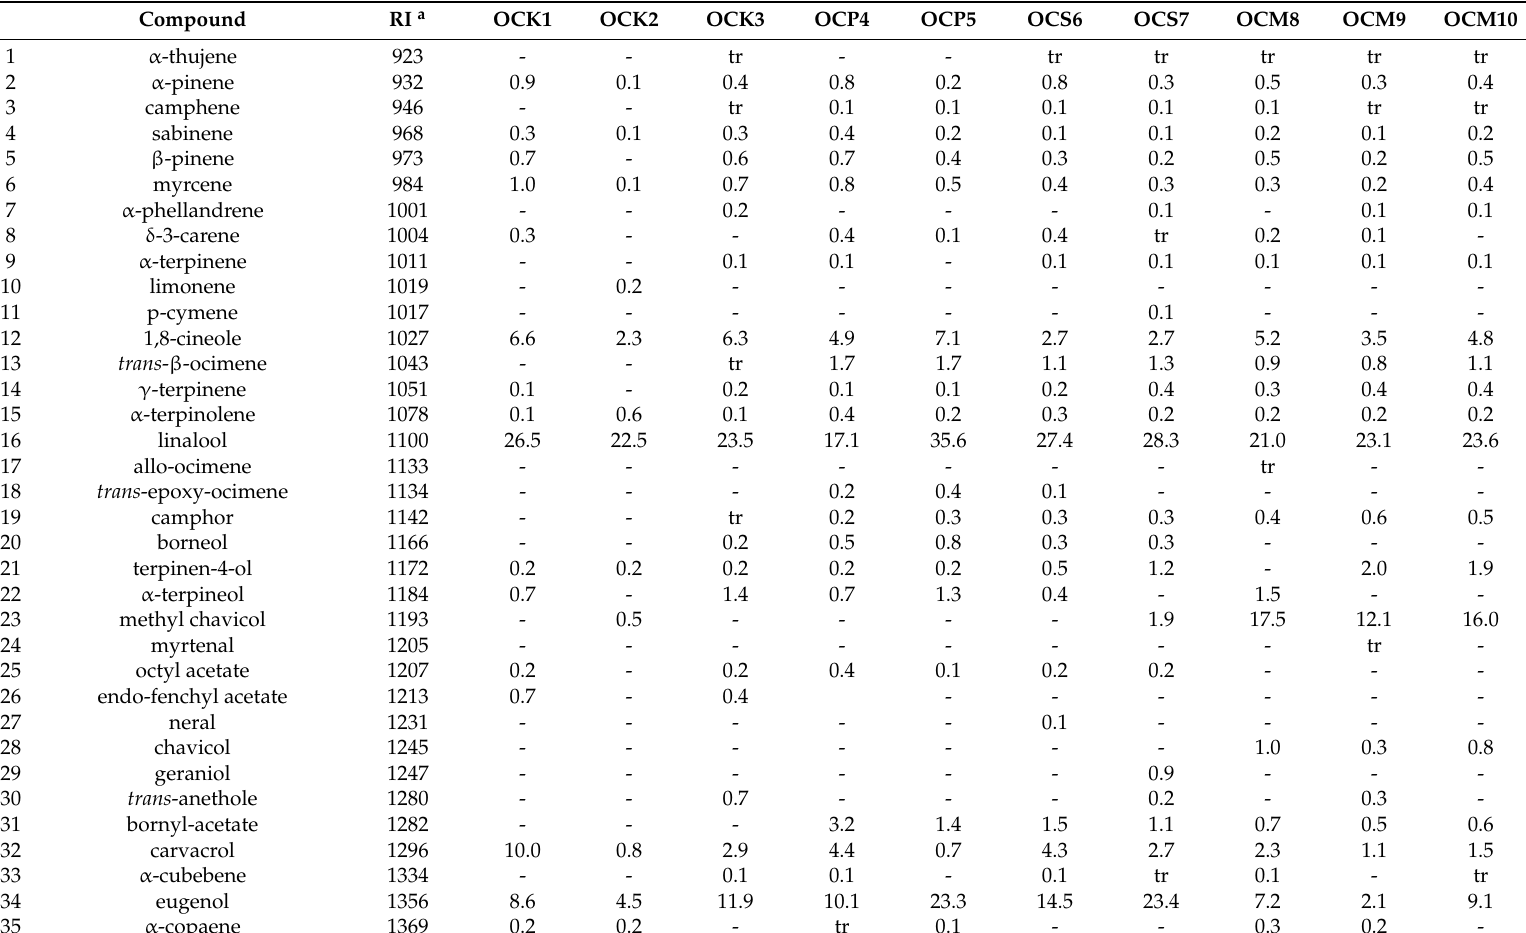
Table 2. Chemical composition of the essential oils from O. basilicum L. varieties, violetto, latifolia, minimum and lettuce, cultivated in the greenhouse